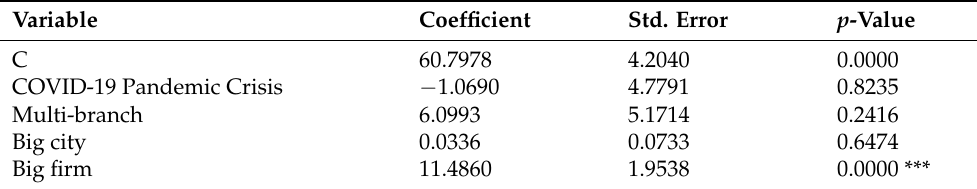
Table 6. The results of the fifth research